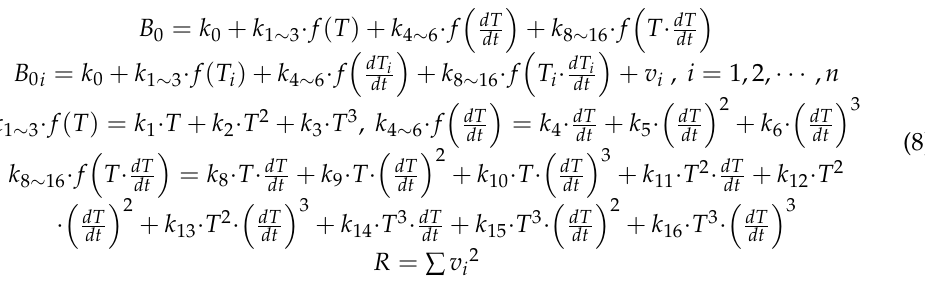
Figure 7. Relationship between gyroscope driving frequency and zero bias under different temper- ature change rate conditions. ( a ) Before compensation. ( b ) After compensation. Table 2. Comparison of the self-compensation effect of each group of data. Type of Data Processing